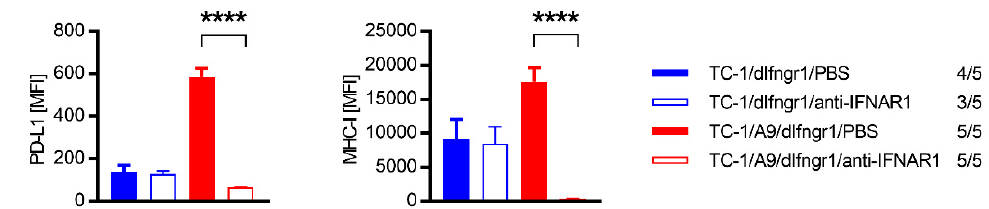
Figure 5. The role of IFN- α and IFN- β in TC-1 / dIfngr1- and TC-1 / A9 / dIfngr1-induced tumors. Cells (3 × 10 4 ) were s.c. injected into C57BL / 6 mice ( n = 5) to form tumors. Mice were treated with anti-IFNAR1 antibody, or PBS was injected as a negative control. Cells isolated from tumors were stained by specific antibodies and analyzed by flow cytometry. The ratio of mice with tumor to the total number of mice in the group is shown. Median fluorescence intensity, MFI; columns, means of analyzed samples; bars, ± SEM; **** p < 0.0001.